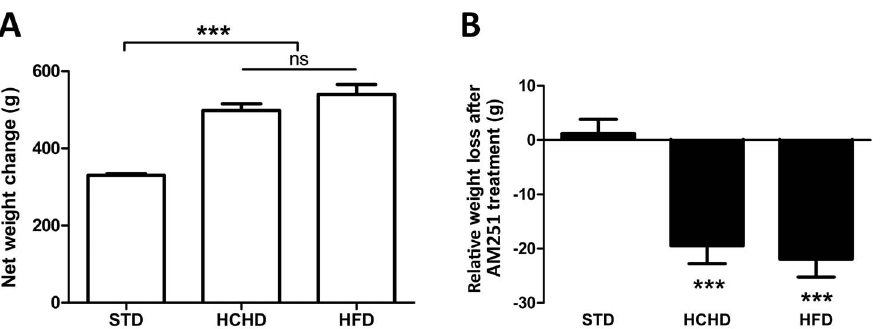
Figure 1. Effect of AM251 on body weight in rats fed standard or obesogenic diets. Net body weight gain was evaluated in rats fed for 10 weeks on a STD, HCHD or HFD. Columns are means 6 SEM (n=16 animals per group). Data were analyzed by one-way ANOVA and Bonferroni’s post- hoc test. *** p , 0.001 denotes significant differences compared with the STD-fed group ( A ). Relative body weight loss was evaluated in STD, HCHD or HFD-fed animals after 14-day exposure to vehicle or AM251 (3 mg/kg, daily, i.p.). Columns are means 6 SEM (n=8 animals per group). Each pair of treatment groups was analyzed by Student’s t test. *** p , 0.001 denotes significant differences compared with the corresponding vehicle-treated group ( B ).